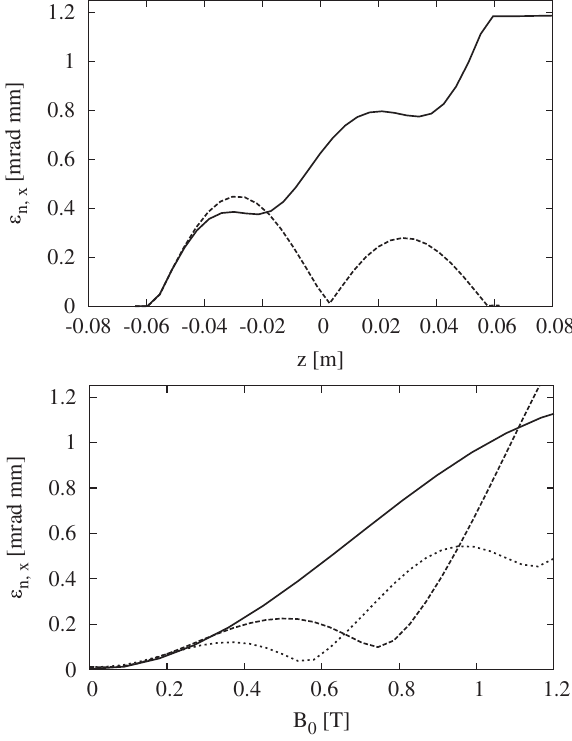
FIG. 21. Top: rms beam size versus strength of the solenoid field for a 5 MeV beam passing through a single-cell cavity (1.3 GHz, E 0 ¼ 50 MV = m, on crest). The analytical result (dashed line) deviates between 0.5 and ∼ 2 T from the numerical result (solid line). Both results converge for high fields to the incoming beam size of 0.75 mm. Bottom: Numerical result for the emittance as a function of the strength of the solenoid field, all parameters as for the top plot (bunch length, ϕ m ¼ 4 . 68 °).